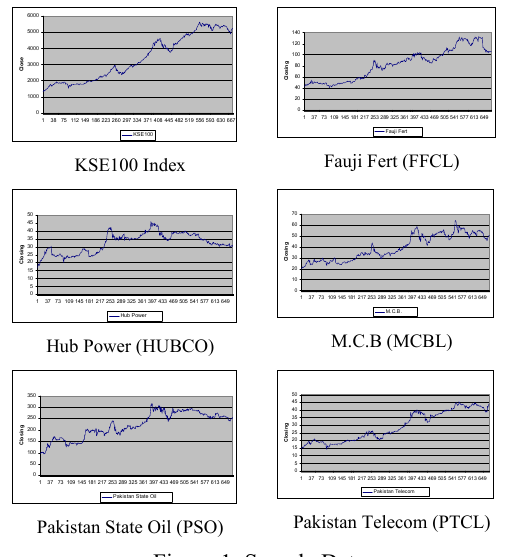
Figure 1: Sample